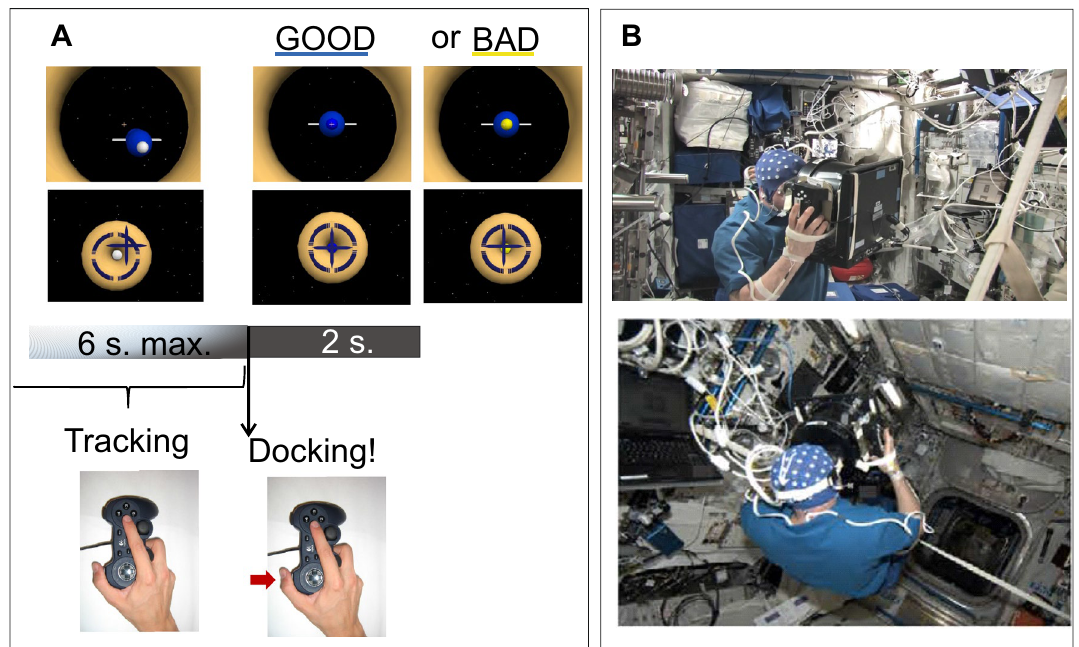
Figure 6. Experimental settings. ( A ) Scheme of the task sequence. After a visuo-motor tracking period for matching positions between spaceship and target (two scenarios), astronauts pressed the button of a joypad to execute the docking. Note the blue centre of the spaceship colored in blue or yellow to inform astronauts of the good or bad performance. ( B ) Astronaut during weightlessness (free-floating) performing the experiment (from Cebolla et al. 6